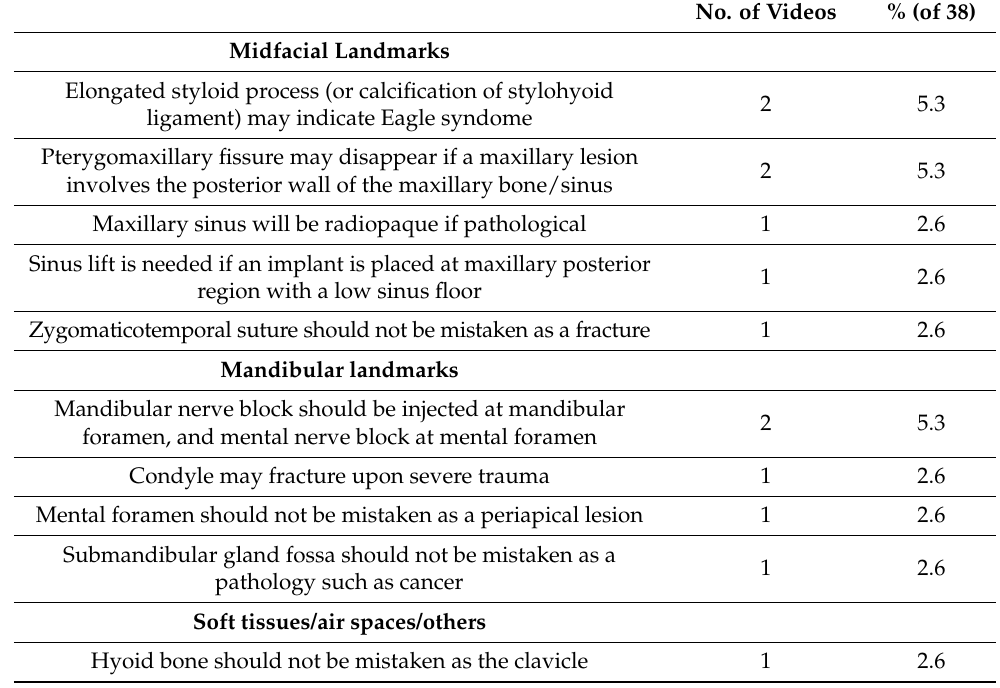
Table 2. Details of clinical relevance of the anatomical landmarks by the videos.